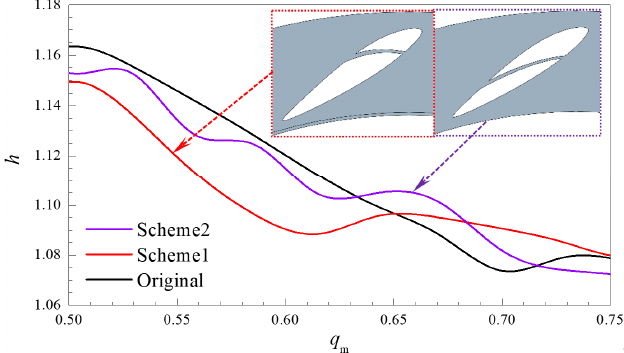
Figure 7. Comparison of calculated results of different schemes.